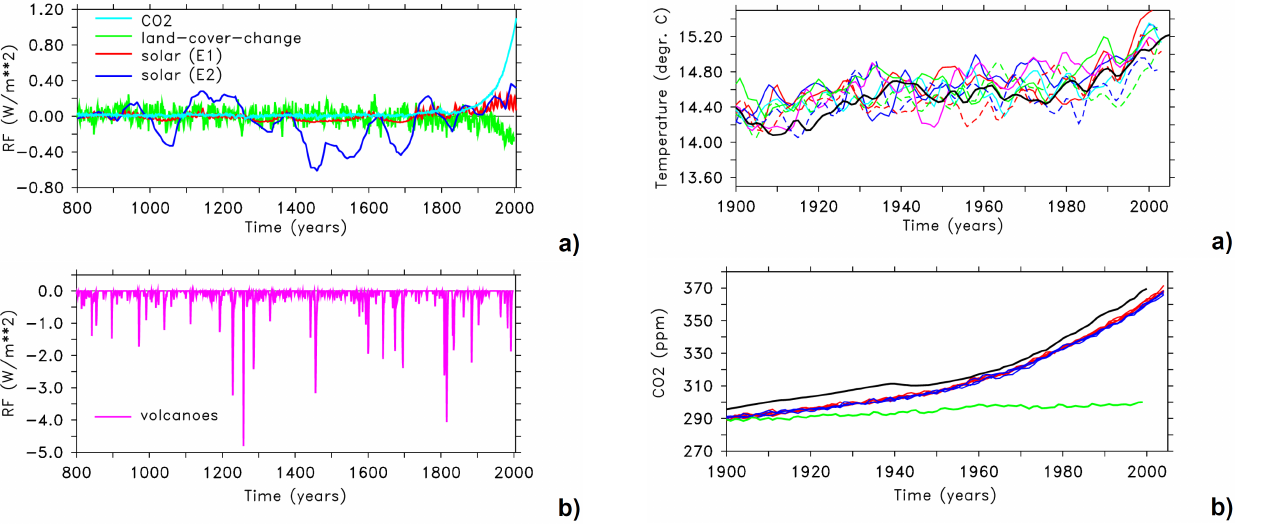
Fig. 1. Radiative forcing at the top of the atmosphere displayed as annual means (a) for the greenhouse-gas forcing (CO 2 ) , land-cover- change (albedo effect only), and solar forcing, and (b) for volcanic forcing displayed with a different axis. Anomalies from solar irra- diance and CO 2 variations are calculated w.r.t. their pre-industrial control mean (1367Wm − 2 and 280.02ppm, respectively). The radiative forcing from volcanic aerosol injections and land-cover- changes are calculated from dedicated experiments with one single forcing component.